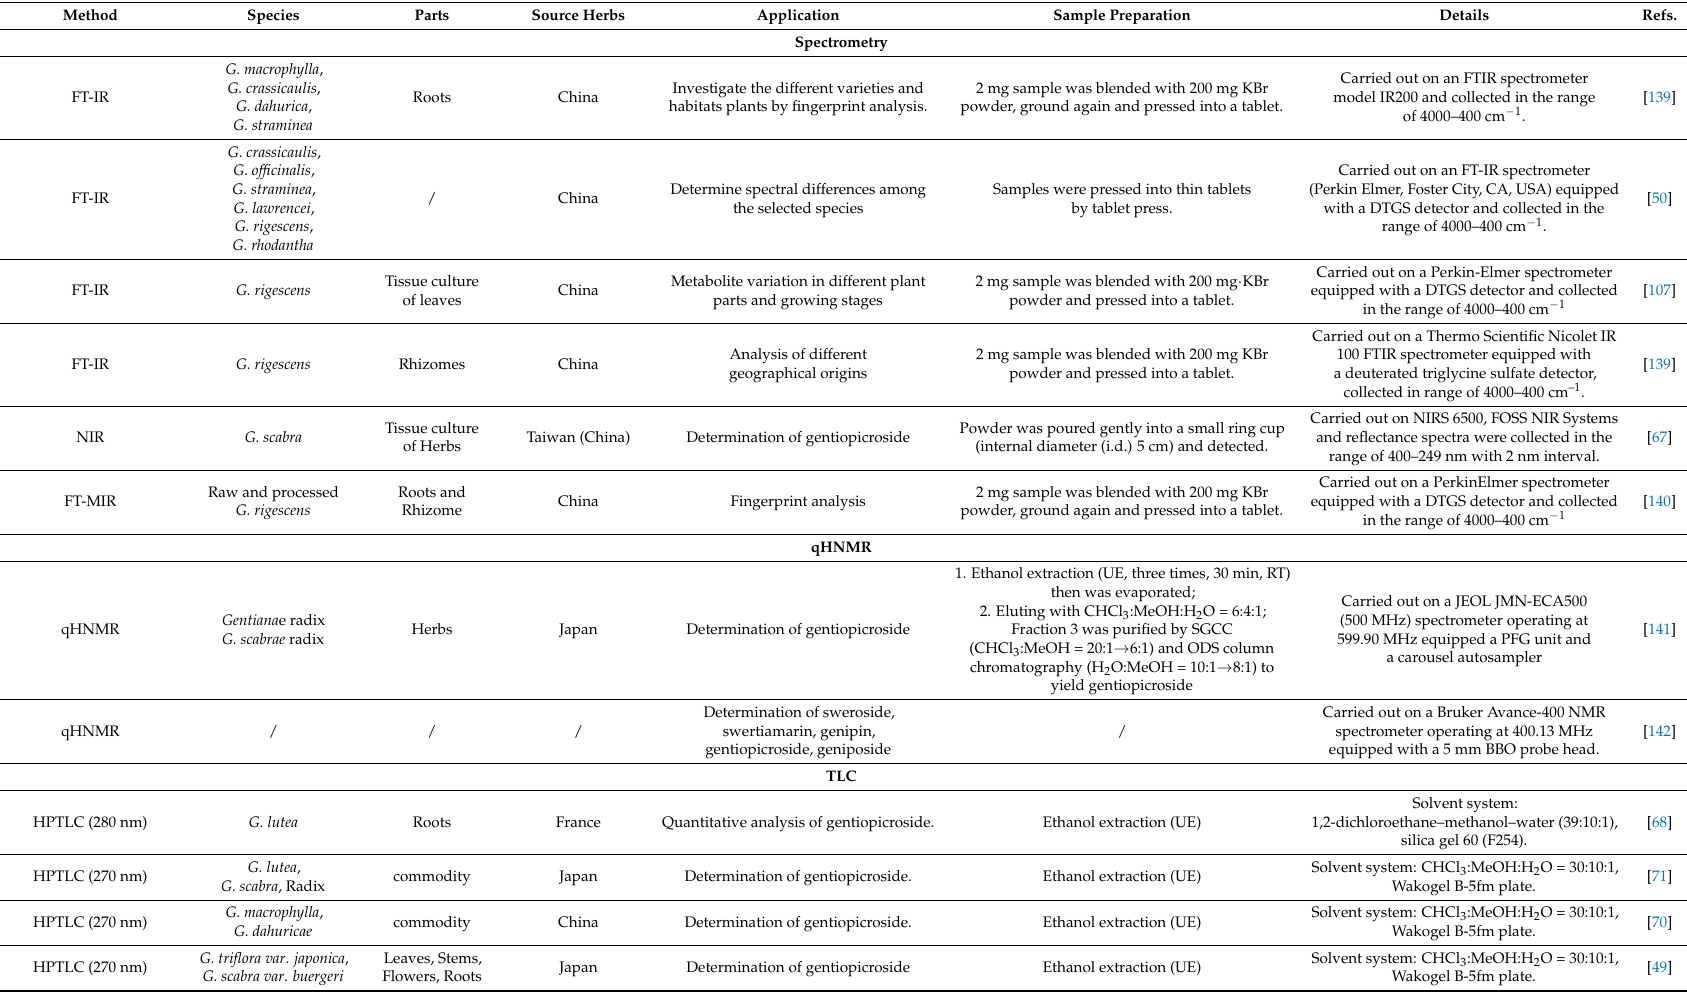
Table 4. Analytical methods of Gentaina